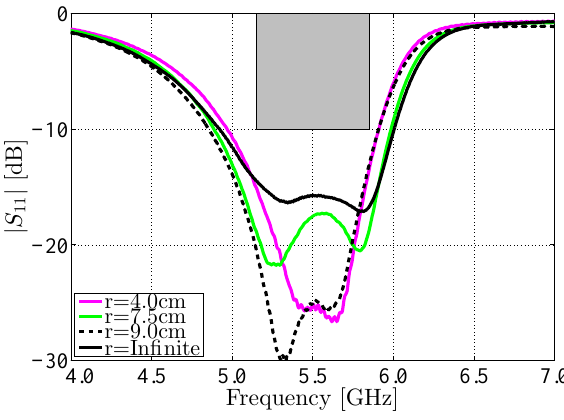
Figure 18. Magnitude of the reflection coefficient | S 1,1 | of the SMA antenna in free space (r = Infinite) compared to the magnitude of the reflection coefficient | S 1,1 | of the same antenna subject to bending around the X-axis, under different curvature radii r.